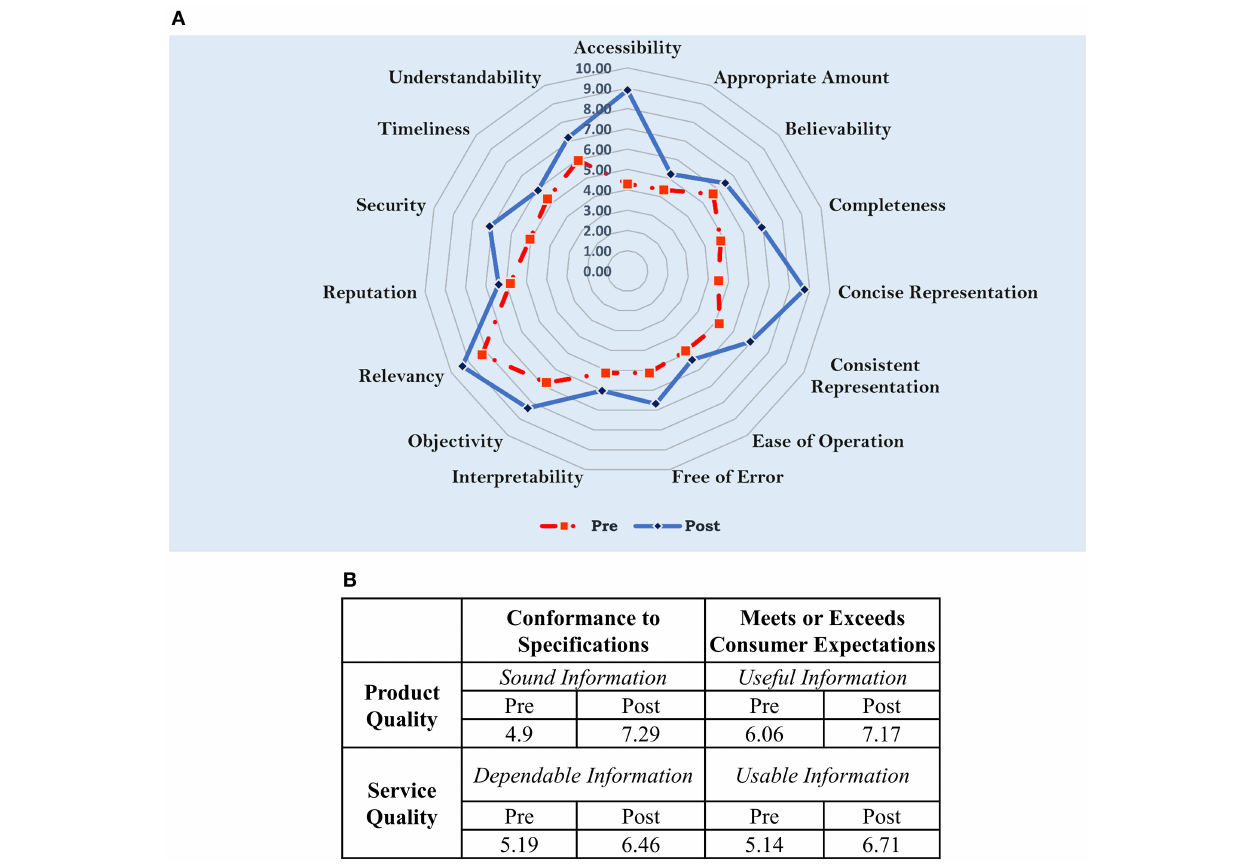
FIGURE 9 | Change in pre- post-optimization information quality (A) impact to each information quality dimension relating to the S&C information flow (B) effect analyzed from the PSP/IQ